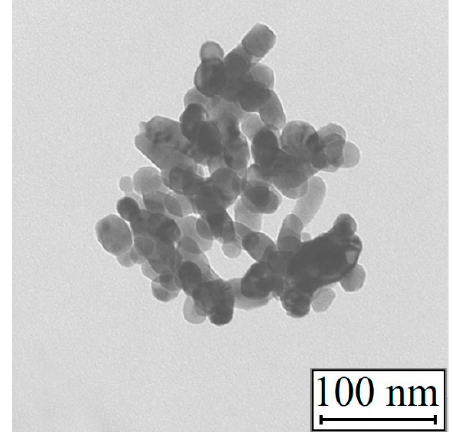
Figure 11. TEM images of the nickel oxide.